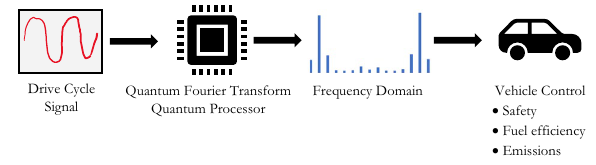
Figure 1. Quantum Fourier transform for drive cycle